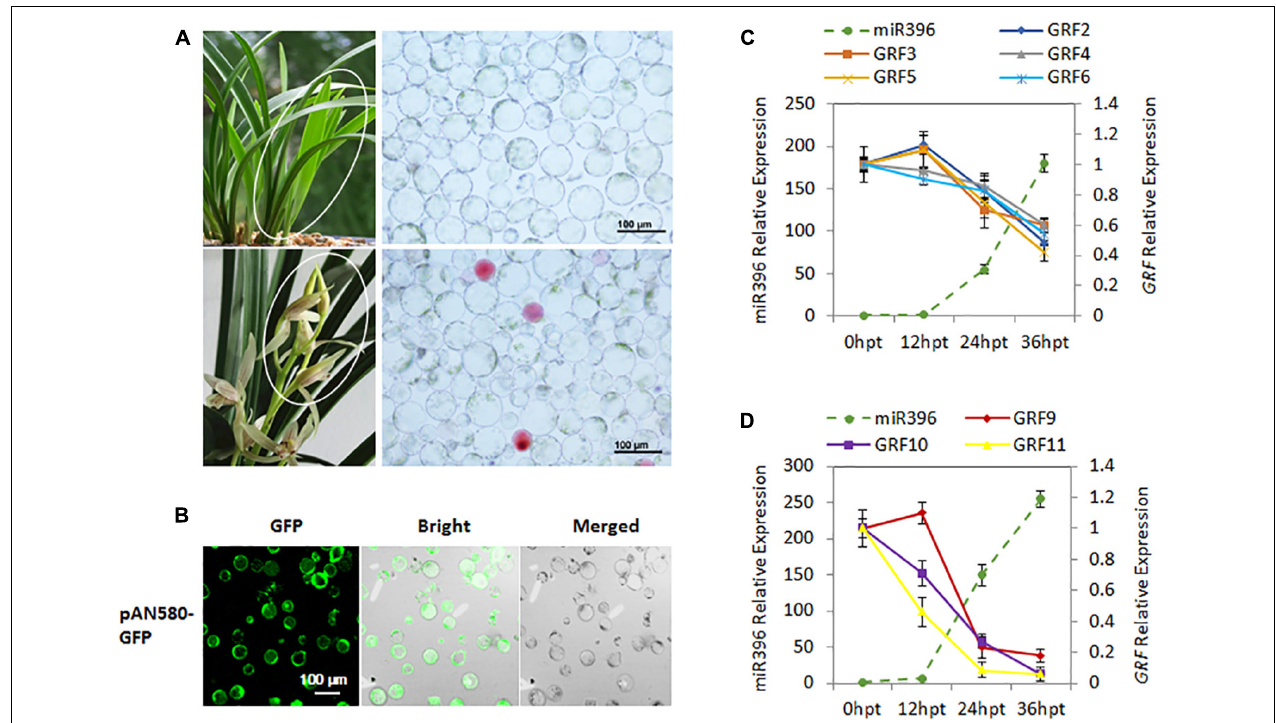
FIGURE 5 | Validation of Ce -miR396-Regulated CeGRFs expression in a C. ensifolium Protoplast-Based Transient Expression System. (A) Protoplast isolation from the leaves (top) and flowers (bottom). (B) Efficient protoplast-based transient expression system (PTES) in Cymbidium ensifolium . The green fluorescence of the GFP reporter is clearly visible in most cells. The maximum transfection efficiency of pPAN-580-GFP (4.71 kb in size) was ∼ 80%. Bar = 100 µ m. (C,D) Transcript levels of Ce -miR396 (dotted line) and CeGRF genes (solid lines) in leaves (C) and flowers (D) . Mature Ce- miR396 was successfully overexpressed in Cymbidium protoplasts 24–36 h after transfection, and the expression levels of CeGRFs were significantly reduced. The Y-axis indicates fold change in expression at different time points. Expression levels were normalized using the threshold cycle values obtained for the Ubiquitin gene. Error bars indicate the standard deviation of the mean (SD) ( n = 3). Three replicates were analyzed, with similar